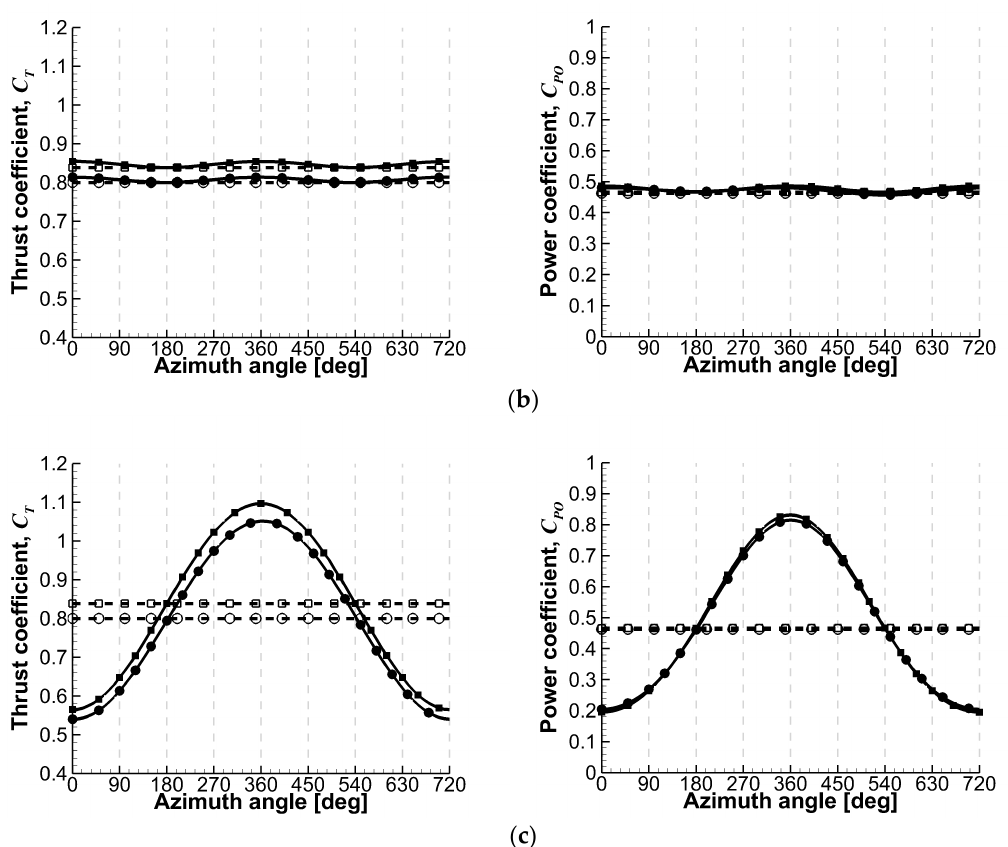
Figure 9. Rotor thrust and power coefficients under translational platform motions. ( a ) Heave motion. ( b ) Sway motion. ( c ) Surge motion.